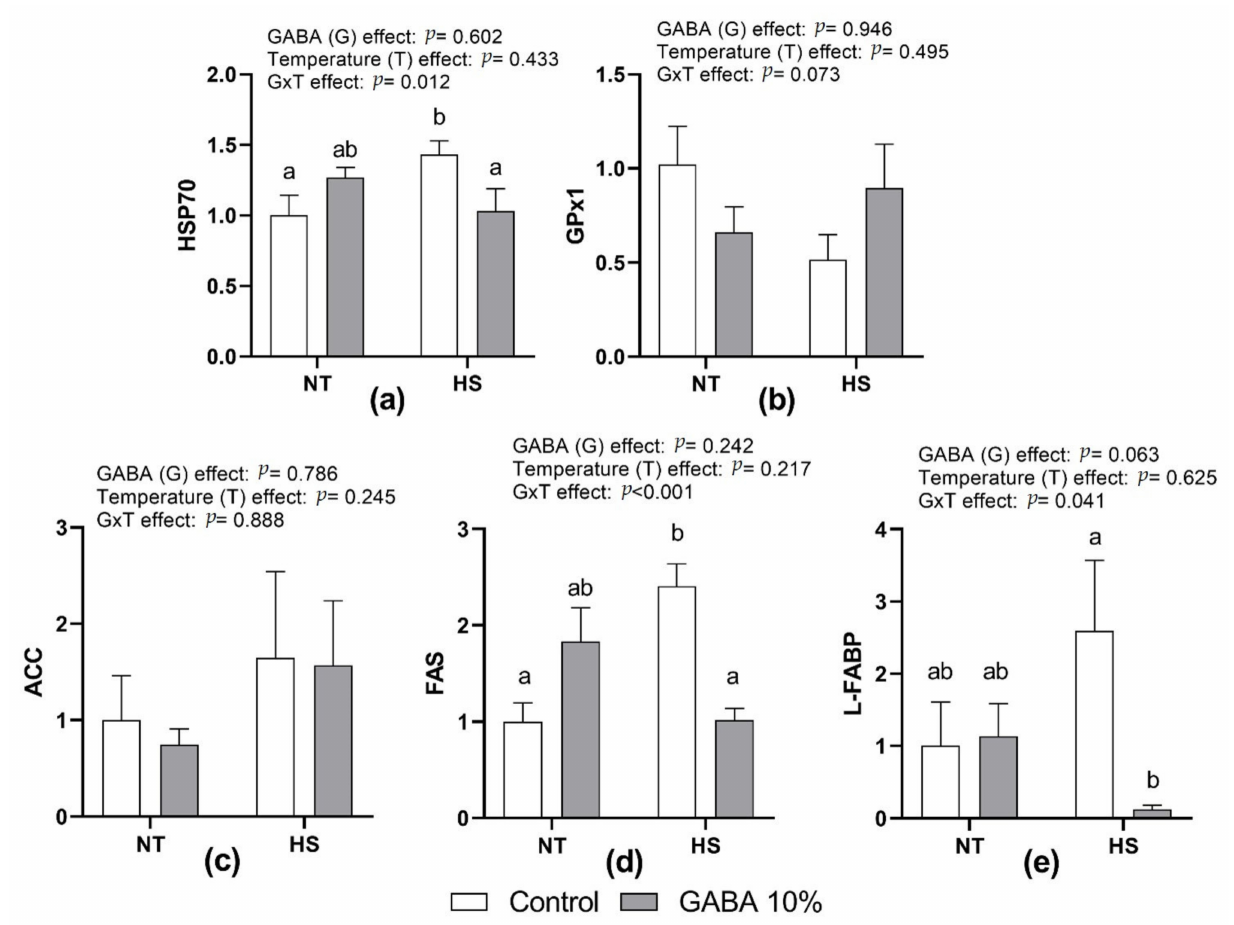
Figure 1. Effects of in ovo injection of GABA on relative mRNA expression of hepatic HSP70 ( a ), GPx1 ( b ), ACC ( c ), FAS ( d ), and L-FABP ( e ) in 10-day-old chicks exposed to acute heat stress for 3 h. At 17.5 days of incubation, eggs were in ovo injected with 0.6 mL of 10% GABA or not. Chicks obtained from each treatment were grown for 10 days, and were then divided into two subgroups. They were subsequently submitted to either heat stress (HS) at 38 ± 1 ◦ C or thermoneutral temperature (NT) at 29 ± 1 ◦ C for 3 h. Data show mean ± SEM (n = 6). a,b: different letters indicate significant differences ( p < 0.05) within all groups. Abbreviations: HSP70, heat-shock protein 70; GPx1, glutathione peroxidase 1; ACC: acetyl Co-A carboxylase; FAS, fatty acid synthetase; and L-FABP, liver fatty acid-binding